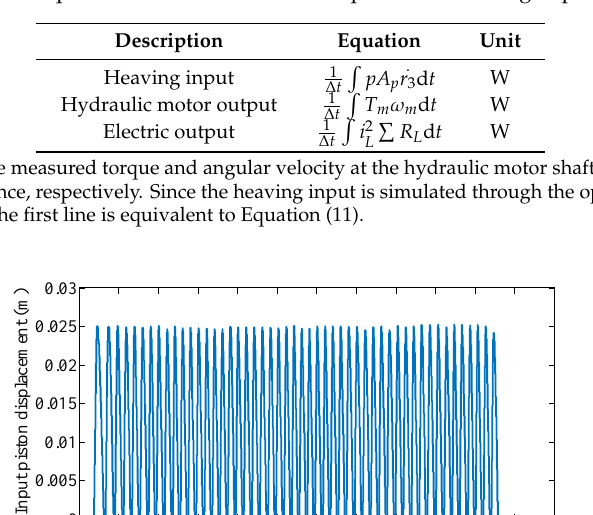
Figure 6. A photo of the WEC core components testbed. A: Laser displacement sensor; B: Manual single cylinder piston pump; C: Compressed nitrogen gas accumulator; D: Torque transducer; E: Gerotor motor; F: Rotary encoder; G: Three-phase 12 V electric generator; H: Three-phase full-wave bridge rectifier; I: Load resistors; J: Solenoid on-off valve; K: Oil reservoir.